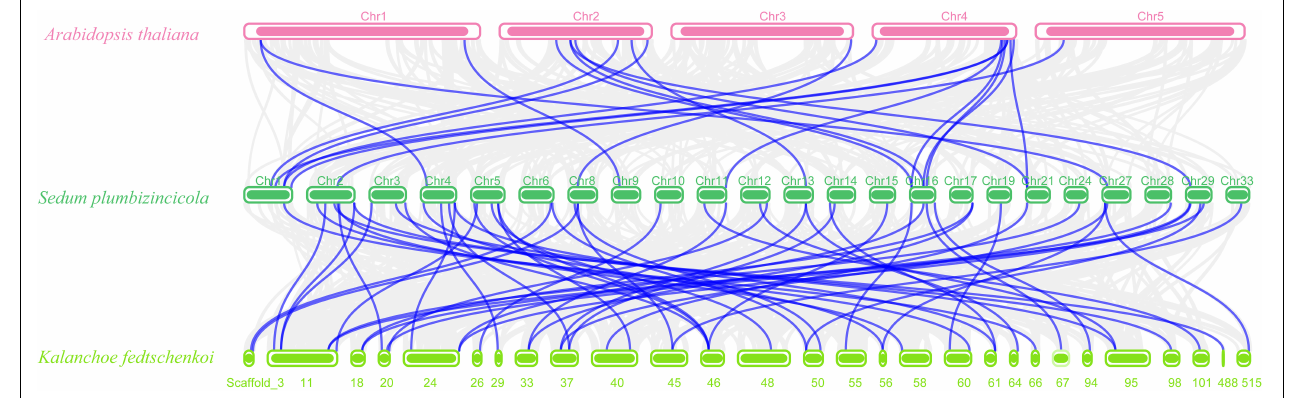
FIGURE 4 | Synteny between SpbZIP genes and genes in other species ( Arabidopsis and K. fedtschenkoi ). Gray lines in the background represent collinear blocks in S. plumbizincicola and the other species, whereas blue lines indicate syntenic bZIP gene pairs.